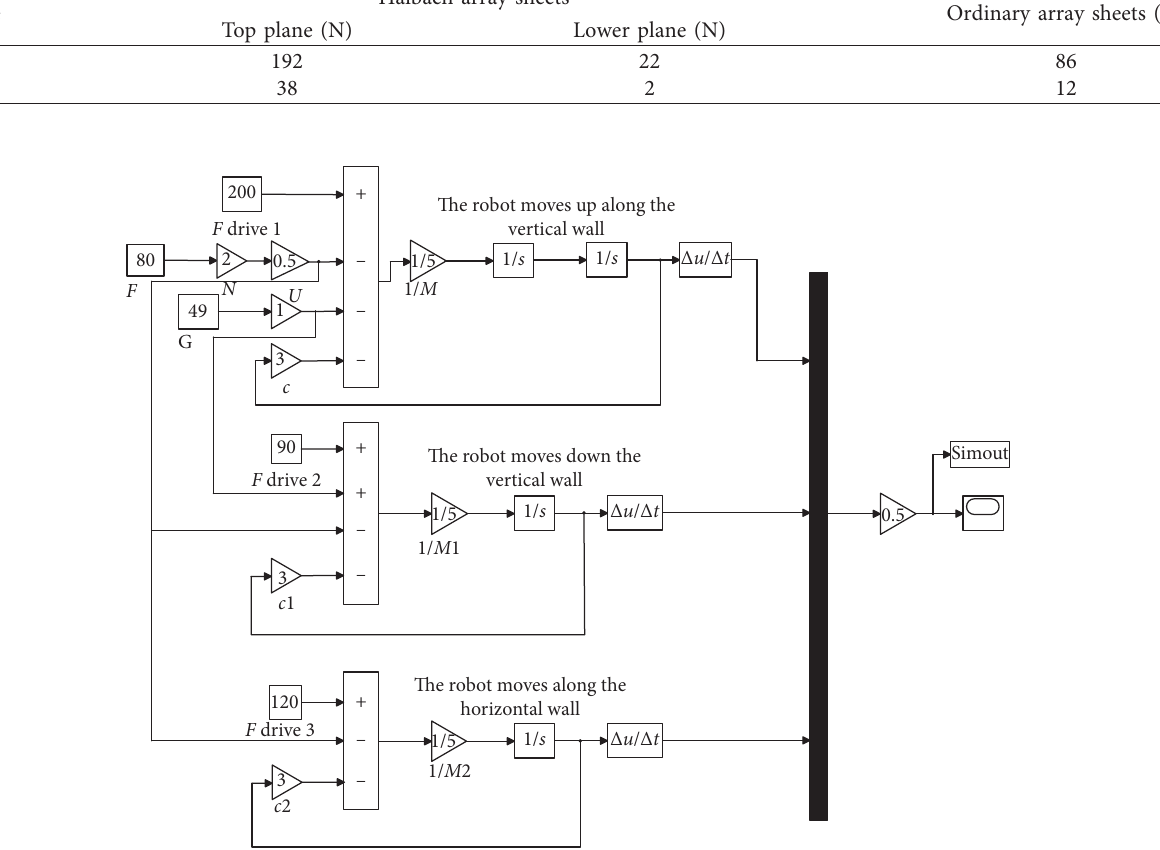
Figure 11: GIS robot control system based on MATLAB/Simulink